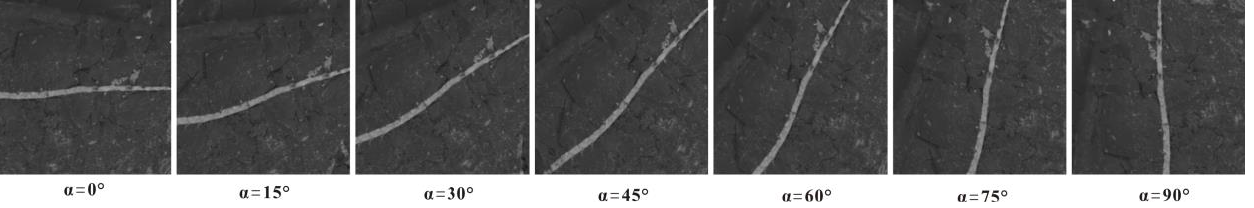
Figure 3. Digital images of coal and rock at different azimuth angles.